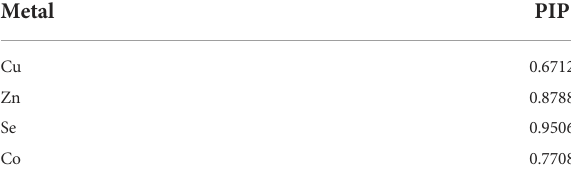
TABLE 4 Posterior inclusion probabilities (PIP) of Ba, As, Pb, Hg by BKMR.